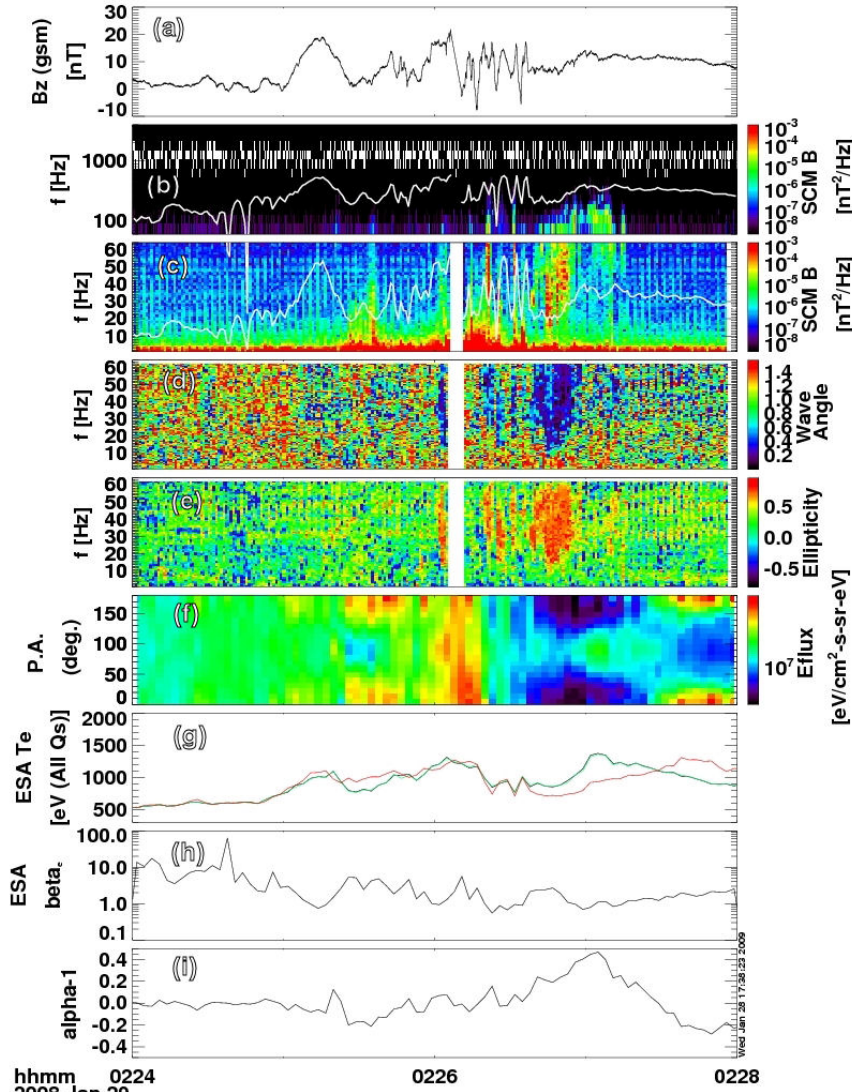
Fig. 6. Panel (a) displays the B z component (128S/s) in GSM coordinates, then same legend as Fig. 4